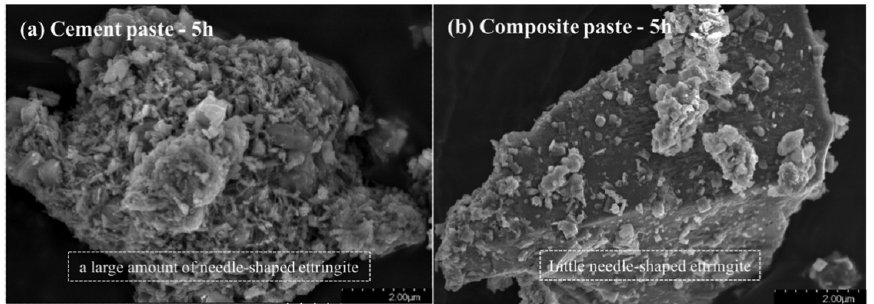
Figure 4. SS inhibits the formation of early ‐ age hydration products, ( a ) the plain cement paste and ( b ) the SS ‐ cement composite paste [75].